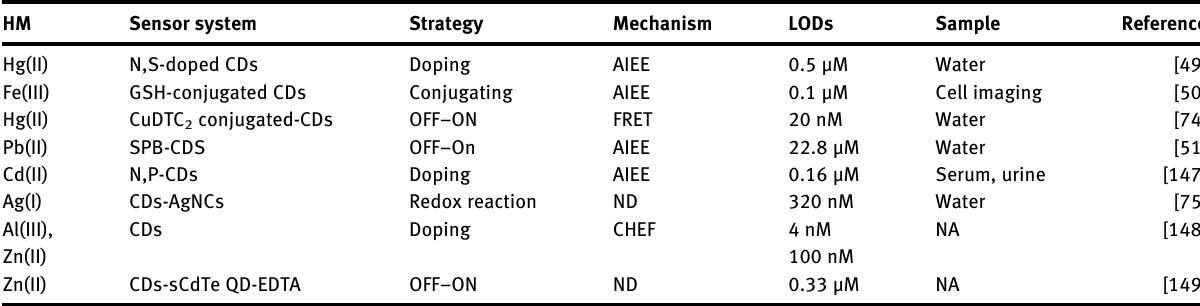
Table  : The applications of CDs as HMs sensor with turn-on signal response.